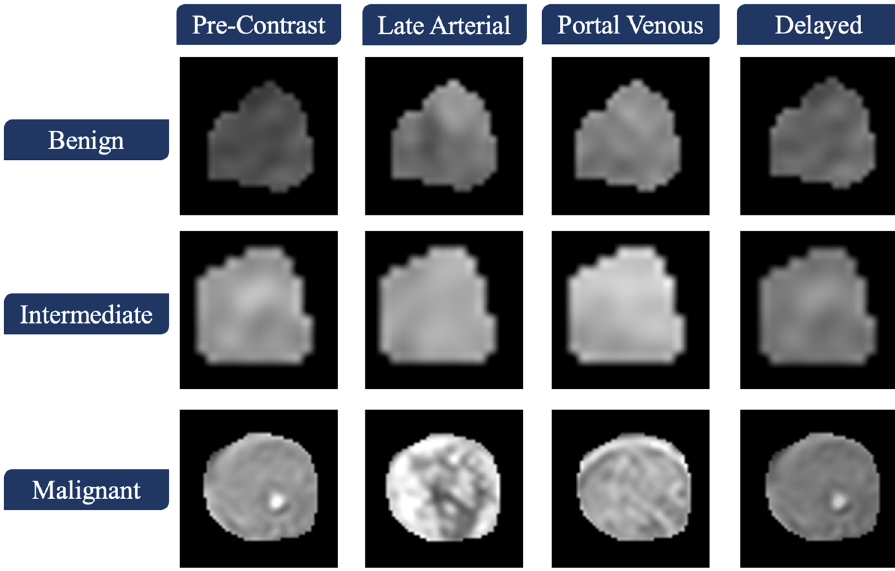
Figure 5. Texture differences visualization between three different tumors, (benign, intermediate, and malignant) at the four different